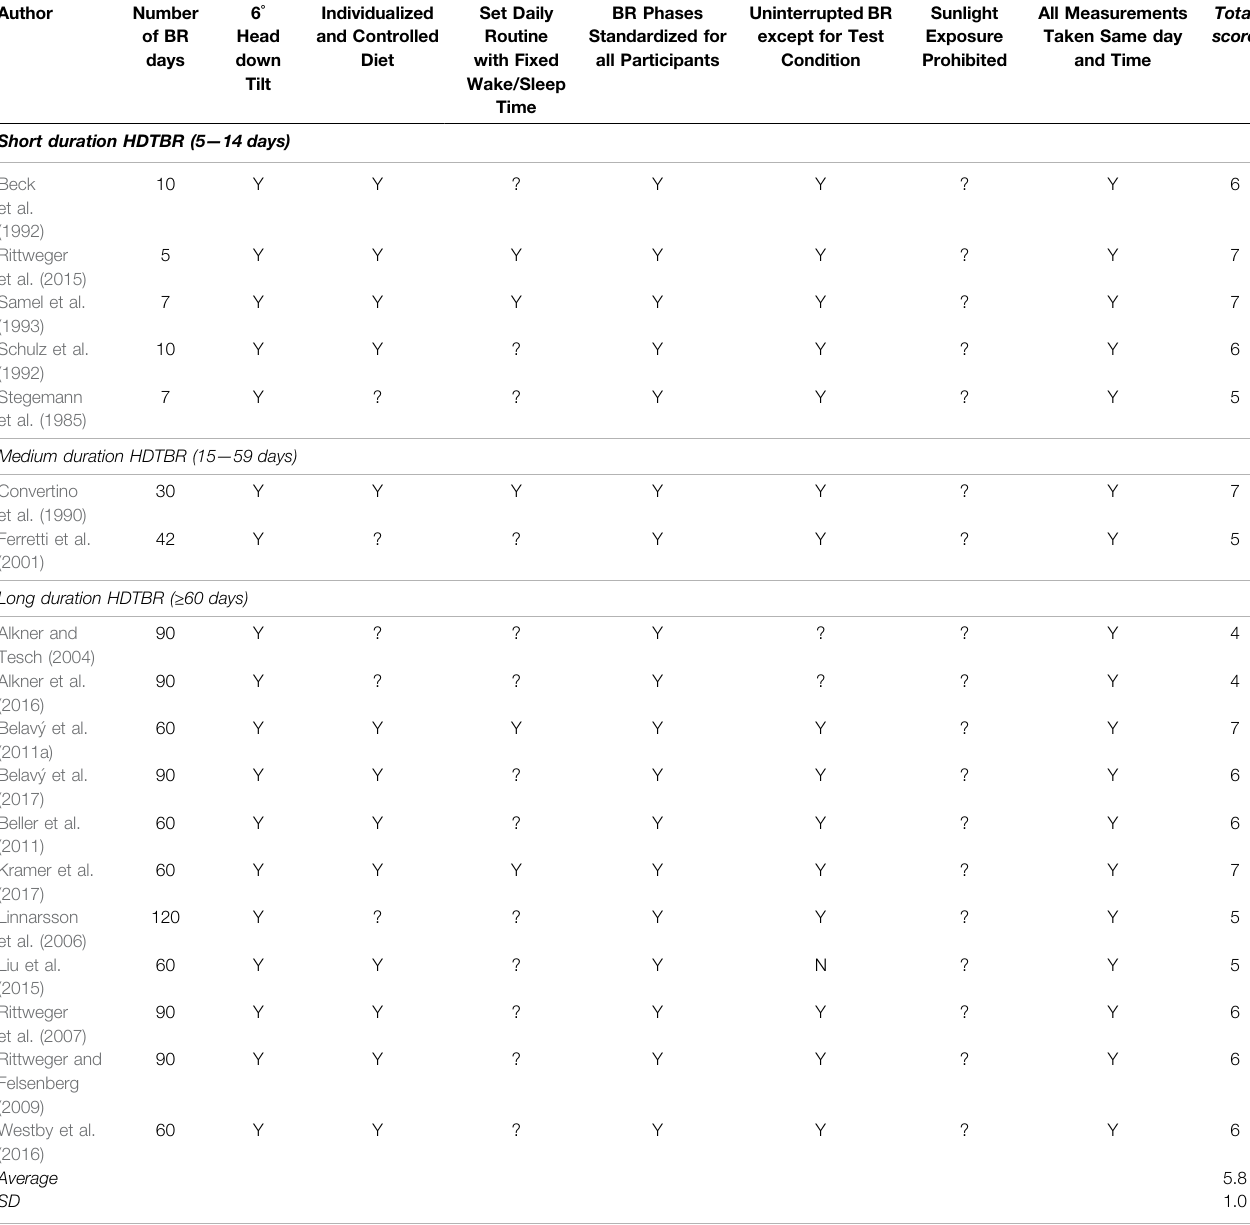
TABLE 1 | Quality appraisal of bed rest method to simulate